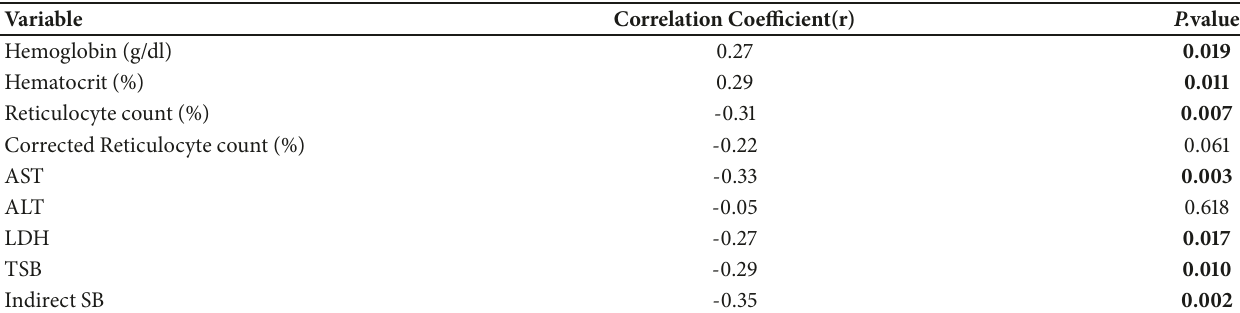
Table 4: Correlation between Serum 25-OHD and biomarkers of intravascular